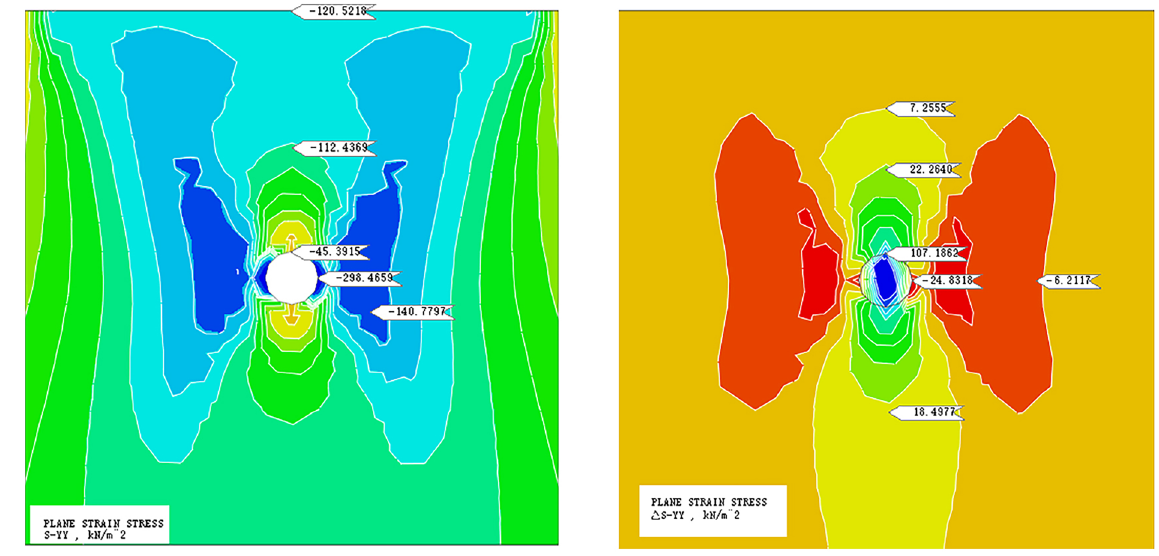
Fig. 4 Redistribution of the vertical stress and the change amount around the